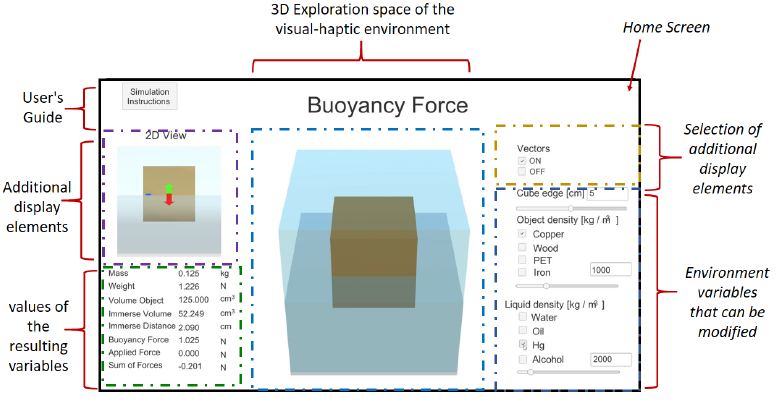
Figure 3. Example of an interface design in a visuo-haptic environment focused on teaching the buoyancy